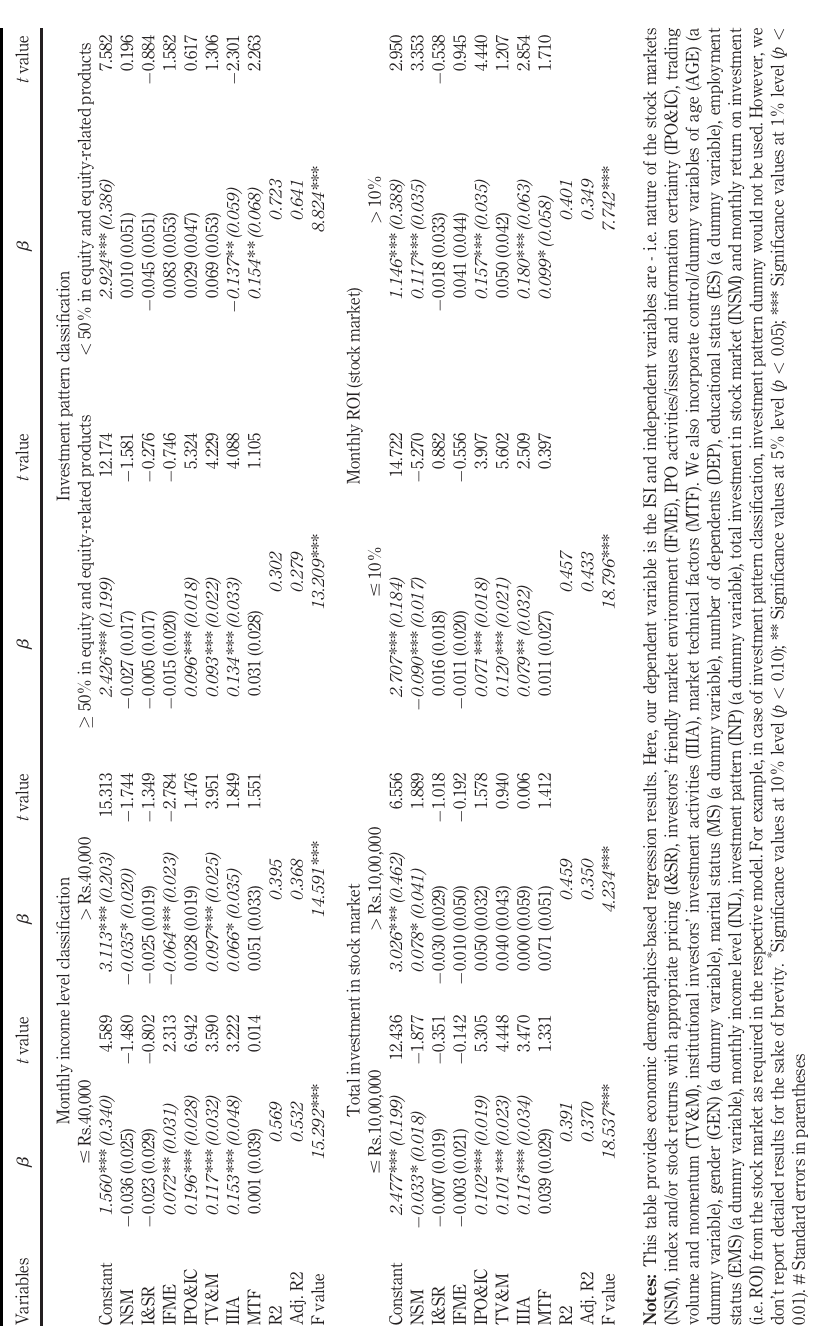
Table 6. Regression results (economic